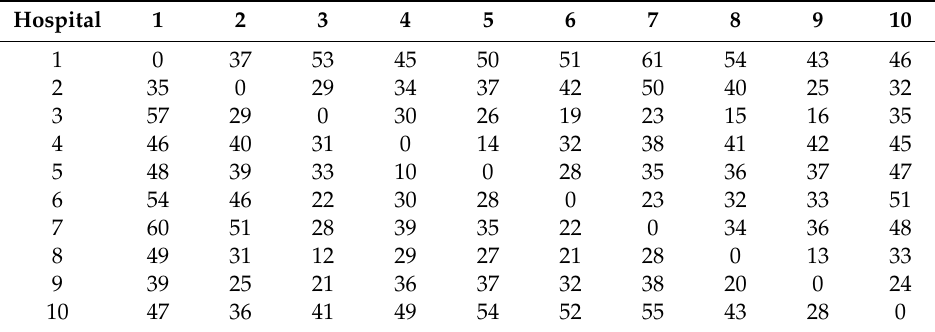
Table A2. Transport time between hospitals